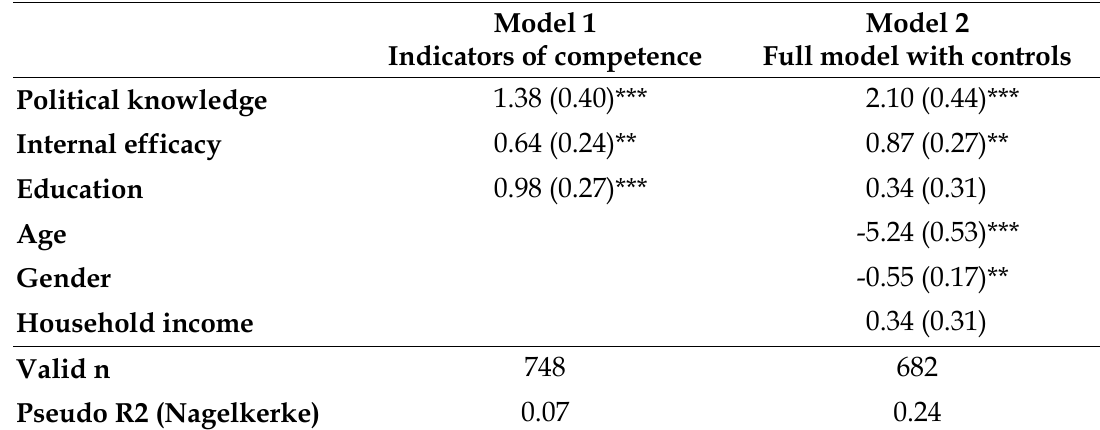
Table 5: Internet activism and digital